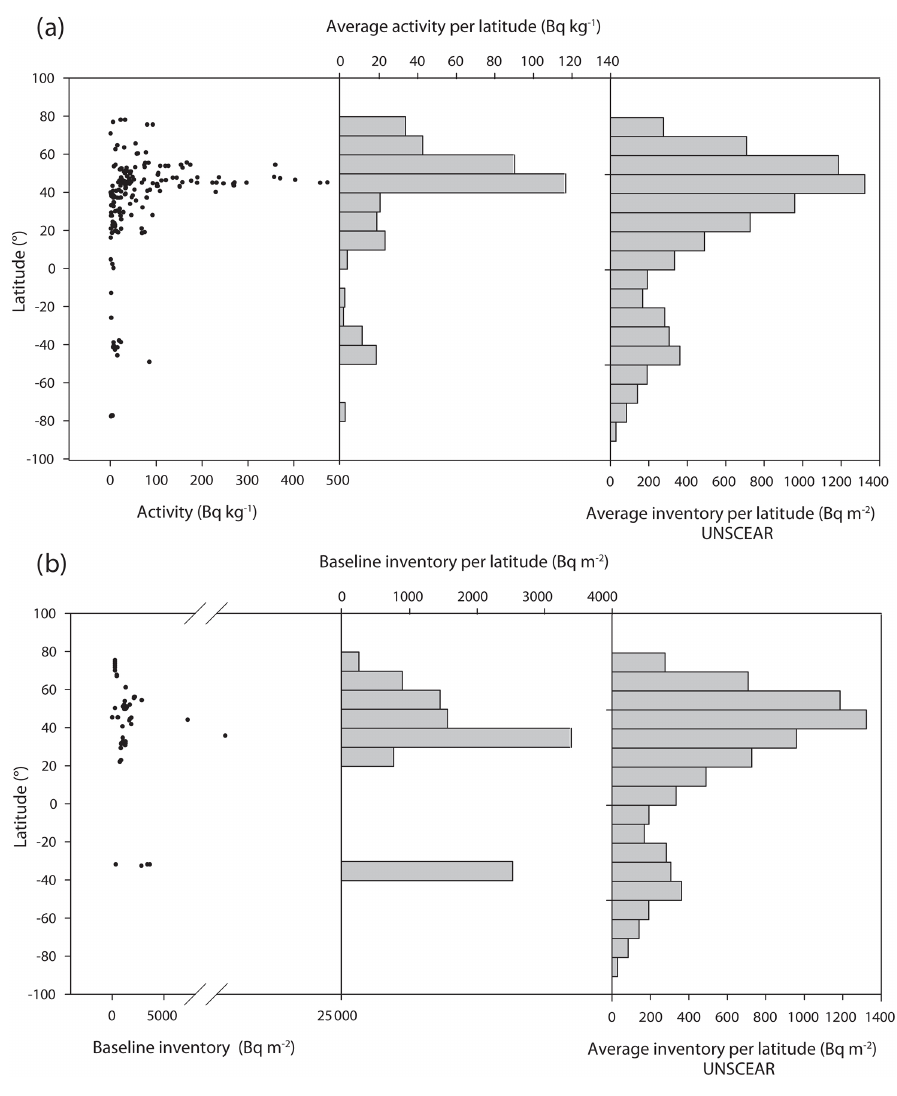
Figure 7. (a) Comparison of latitudinal distribution of 137 Cs activities associated with the atmospheric nuclear tests. From left to right, indi- vidual data collected in sediment cores, average activity per latitude as derived from the current database and average inventory distribution per latitudinal band as derived from the UNSCEAR database. (b) Comparison of latitudinal distribution of 137 Cs baseline inventories. From left to right, individual data collected in sediment cores, average inventory per latitudinal band provided by the database and the average inventory distribution per latitudinal band as from the UNSCEAR